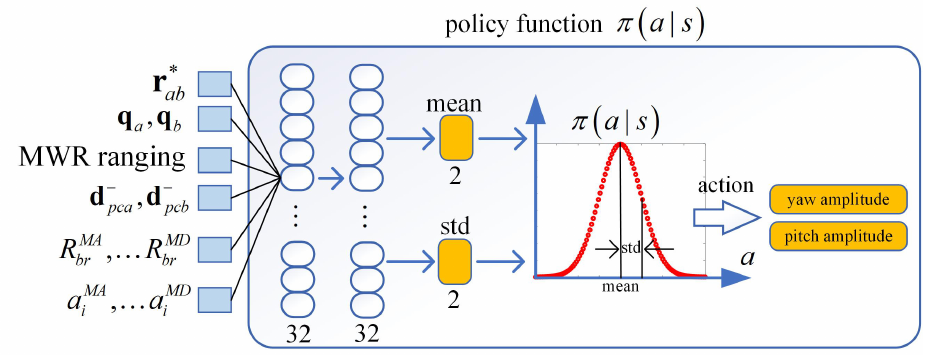
Figure 8. Schematic diagram of actor network.